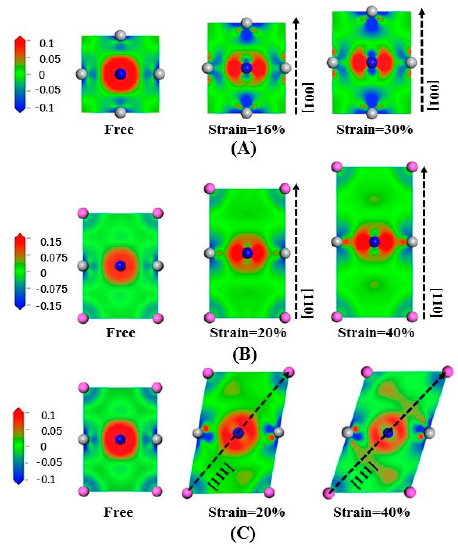
Figure 7. Electron density difference of Ti 3 AlN: ( A ) stretched along [001] in the slice of (200); ( B ) stretched along [110] in the slice of (1 1(cid:3364) 0); ( C ) stretched along [111] in the slice of (1 1(cid:3364) 0).